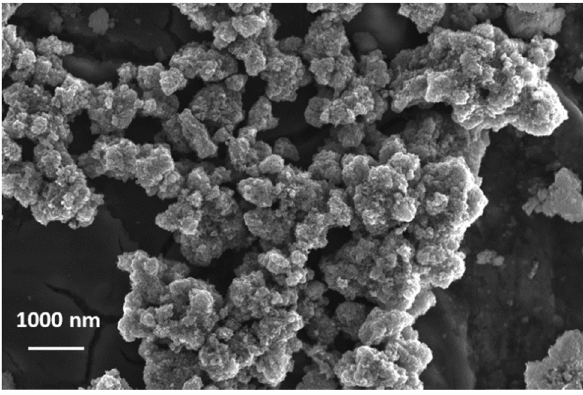
Figure 1: SEM image of metatitanic acid ( 30k × magni fi cations )